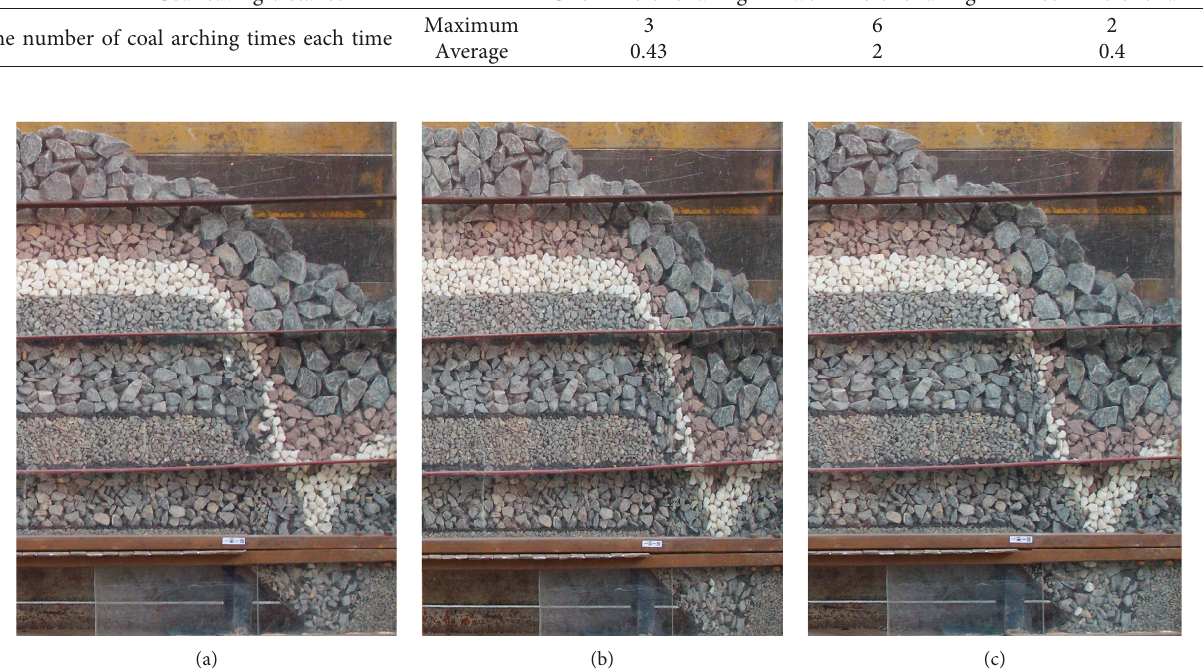
Figure 14: Dump top coal effect of one knife one falling. (a) Before relocation. (b) After relocation and before coal dumping. (c) After laying coal.